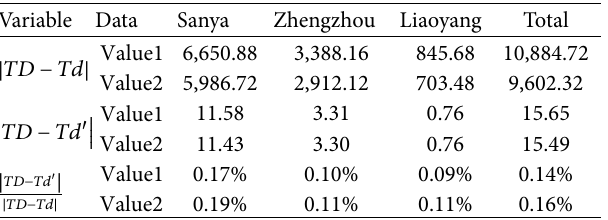
Table 6: Comprehensive results and comparisons of three methods. Unit: m.